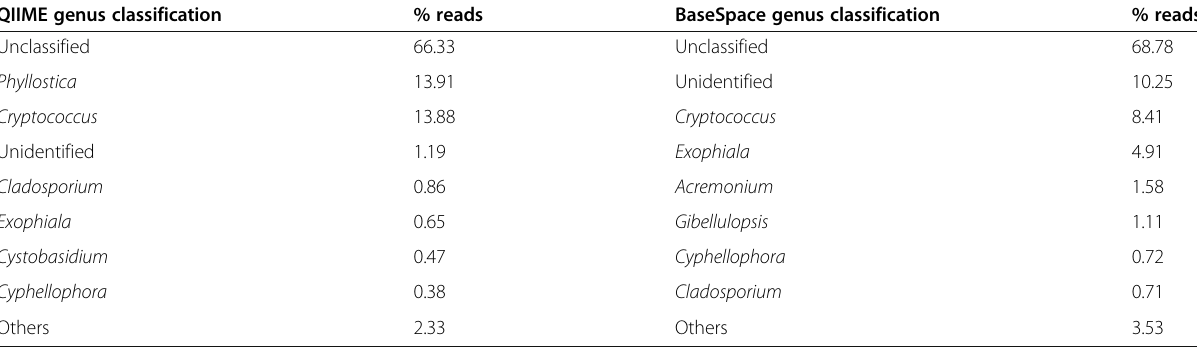
Table 4 Top genus classification results for sample 35, obtained through BSSH and QIIME. The genera Cryptococcus , Exophiala , Cyphellophora , and Cladosporium are present in both the analysis but with differences in the relative abundance QIIME genus